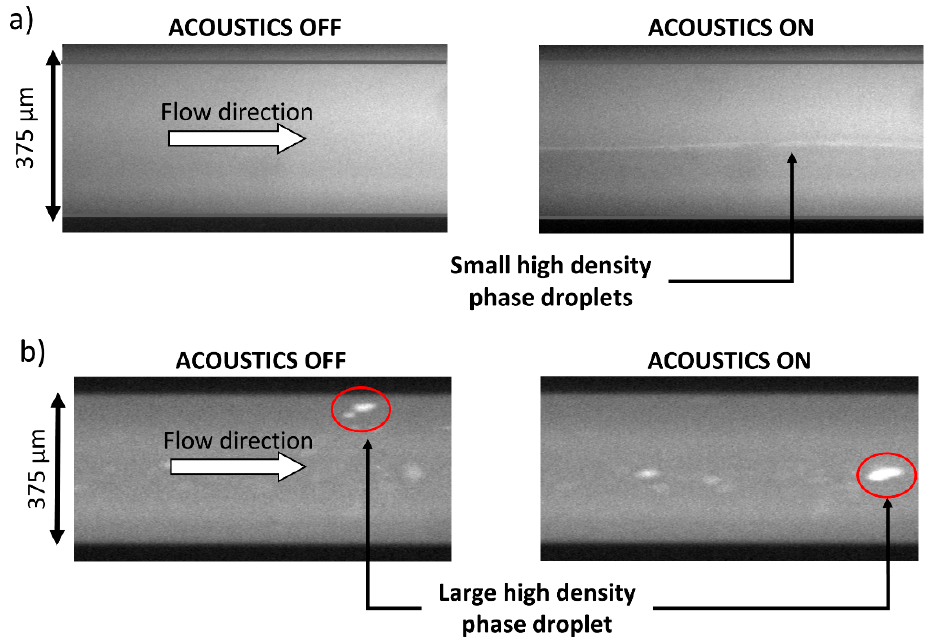
Figure 3. Focusing of high-density droplets. Upon activation of the acoustic field, droplets are focused in the center of the microfluidic channel, with a driving voltage of 25 V p-p . ( a ) Focusing of small droplets in the center of the channel, ( b ) focusing of large droplets.